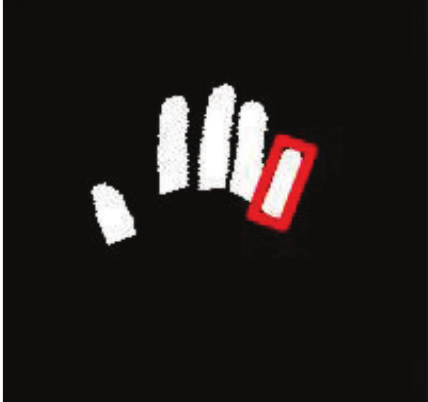
Figure 10: The minimal bounding box.